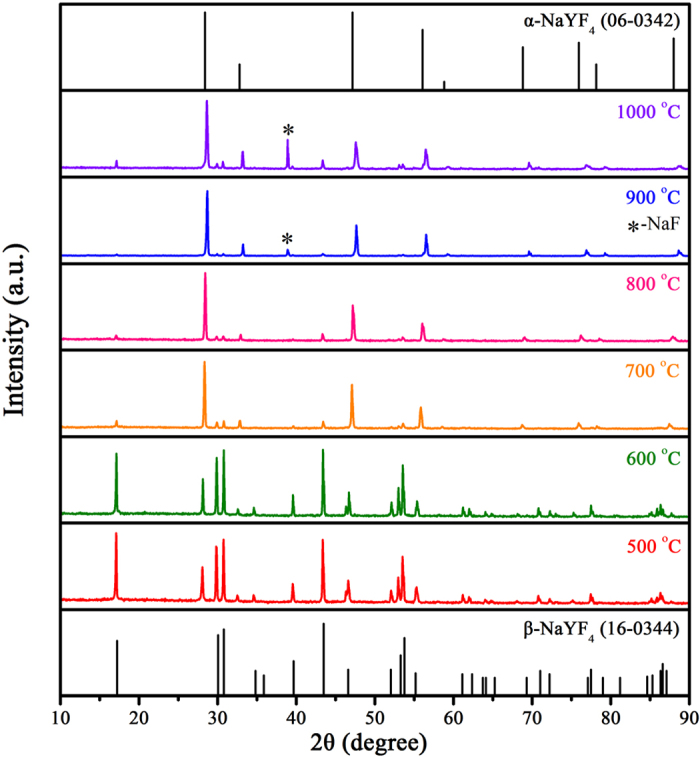
XRD patterns of α-NaYF4:5%Er3+ nanocrystals calcined at different temperatures for 2 h.